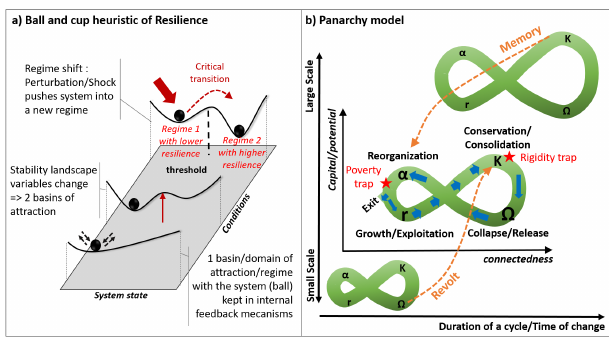
Fig. 1. Resilience thinking representation of social-ecological system dynamics. (A) Ball and cup heuristic of the stability landscape. (B) Panarchy model of adaptive and resilient change (adapted from Gunderson and Holling